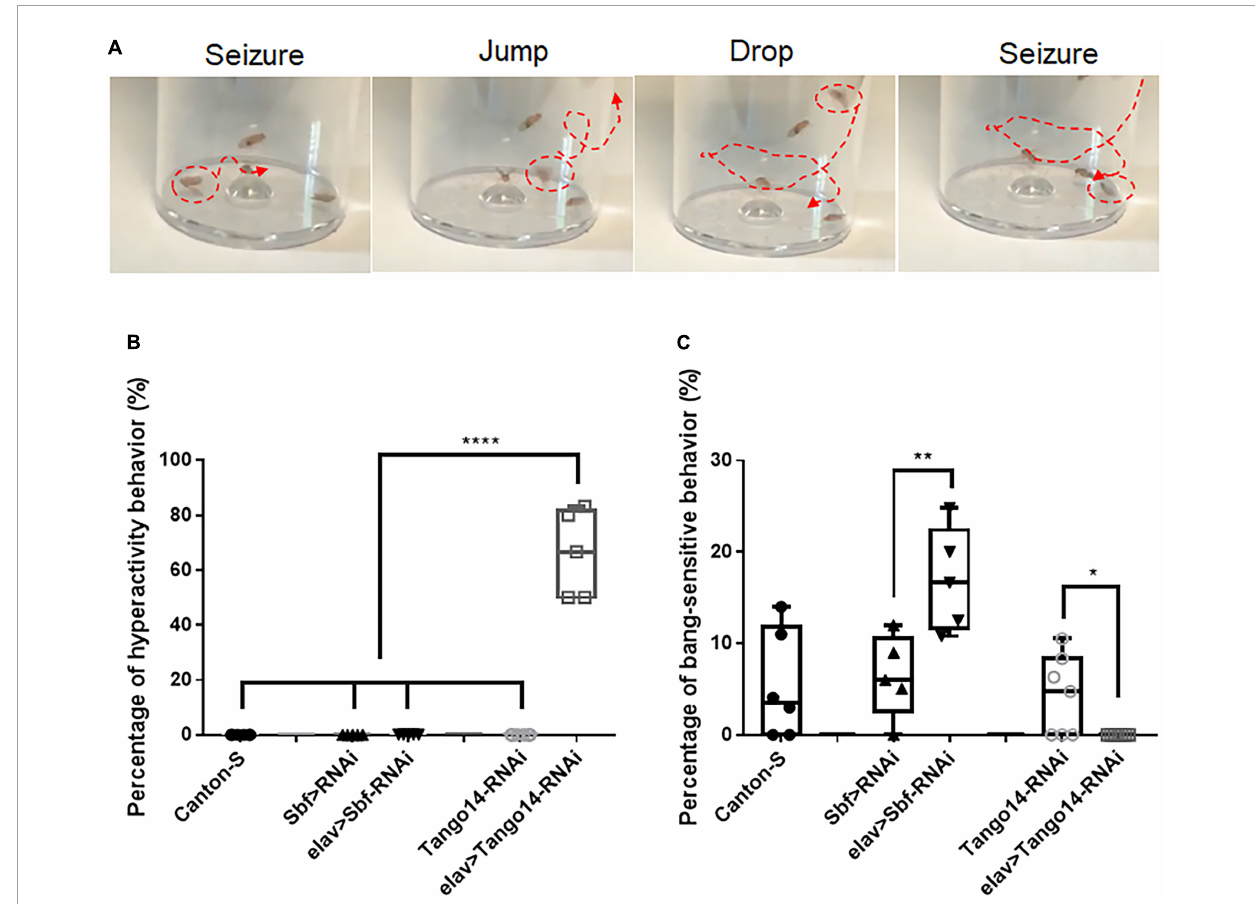
FIGURE1 Hyperactivity seizure behavior in Tango14 knockdown flies. (A) Typical hyperactivity seizure behavior is shown. The seizure stages contain the first-phase seizure stage, the jump-and-drop stage, and the second-phase seizure stage. (B) Approximately 70% of Tango14 knockdown files ( elav > Tango14-RNAi ) showed hyperactivity seizure behavior. Contrarily, the control flies ( Canton-S files and Tango-RNAi flies) did not show any hyperactivity seizure behavior. One-way ANOVA and Tukey’s multiple comparison tests. (C) elav > Sbf-RNAi showed a higher BS seizure rate than that of wild-type flies ( Sbf > RNAi ). While elav > Tango14-RNAi showed no classical BS seizure. ** P < 0.01, **** P <